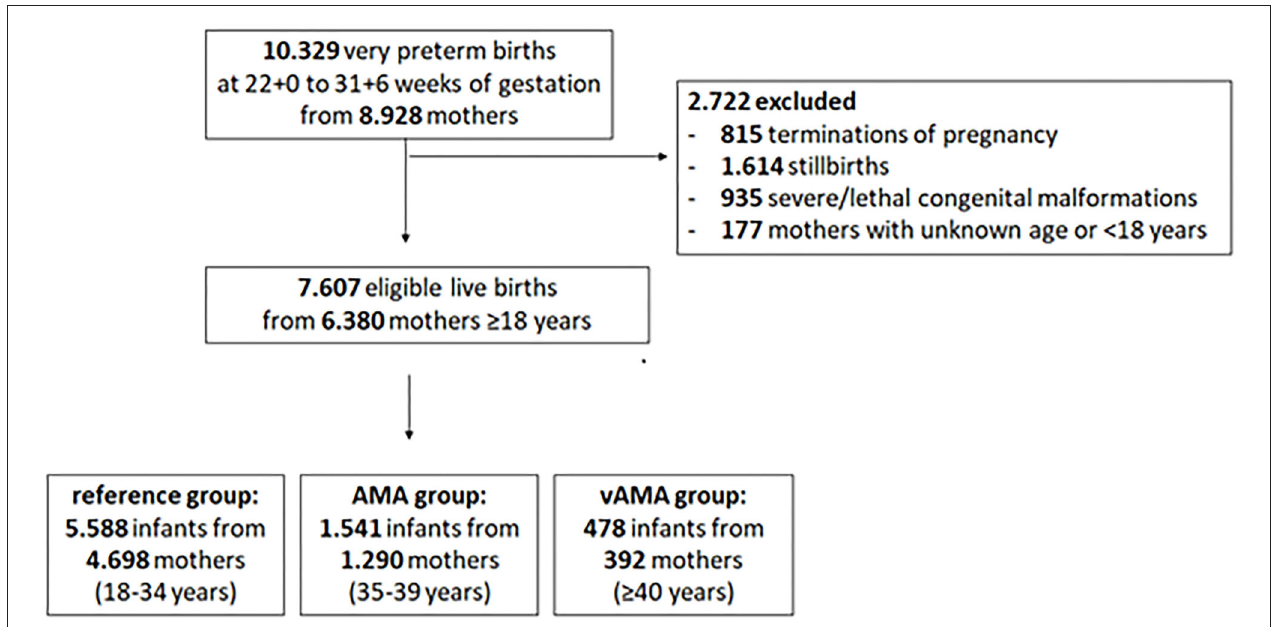
FIGURE 1 | Study population. Flow chart of the EPICE Study population.